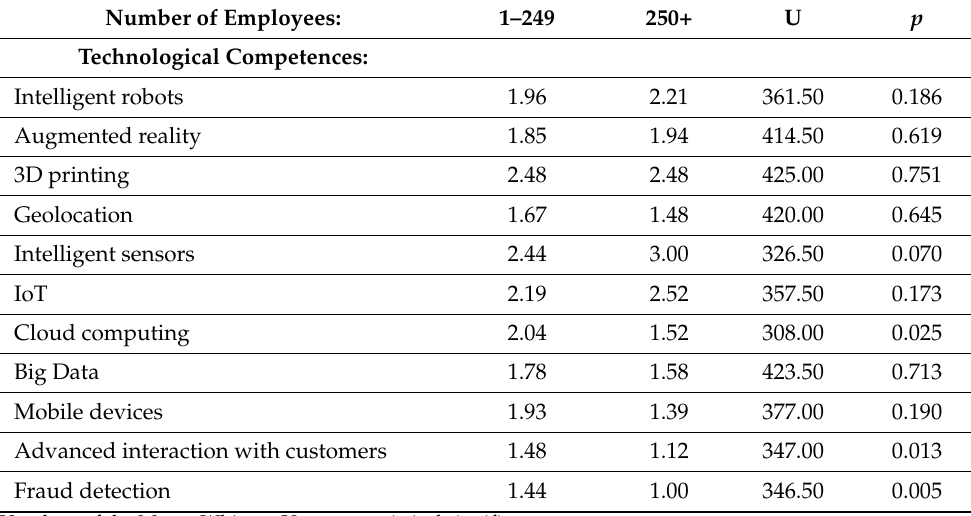
Table 3. Assessment of the respondents’ knowledge about innovative technologies in companies employing up to 249 participants and in companies employing at least 250